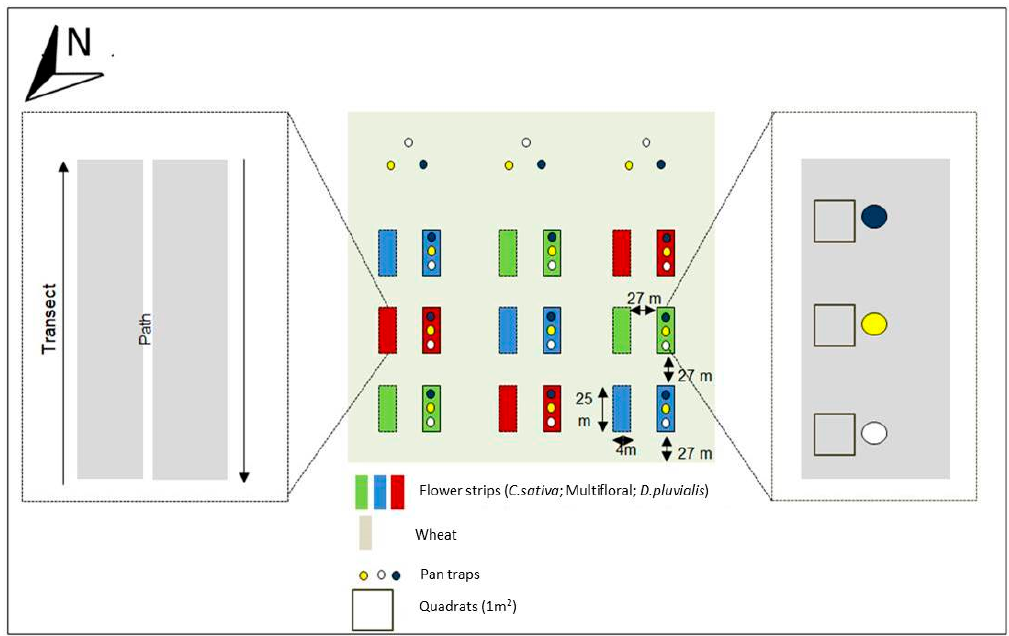
Figure 1. Experimental setup.